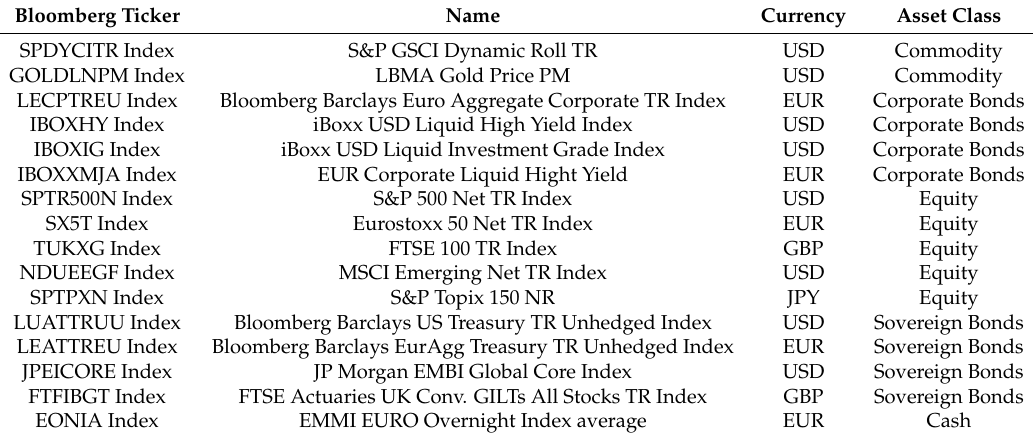
Table 1. Major market indices relative to each currency and asset